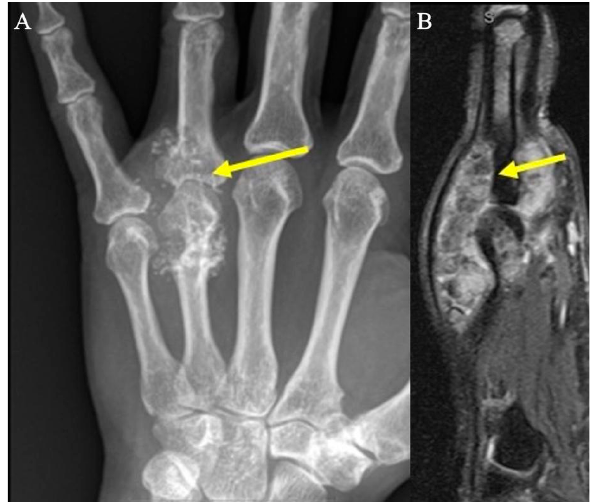
Figure 11. Chondromatosis. ( A ) AP radiograph shows numerous calcified masses with chondroid pattern mineralization at the fourth metacarpophalangeal joint (arrow), with smooth scalloping and extrinsic erosions of the adjacent metacarpal neck and proximal phalanx. ( B ) Sagittal fat ‐ suppressed PD demonstrates numerous hypointense chondral bodies (arrows) along both the flexor and extensor tendons, scalloping the bone, consistent with synovial chondromatosis.